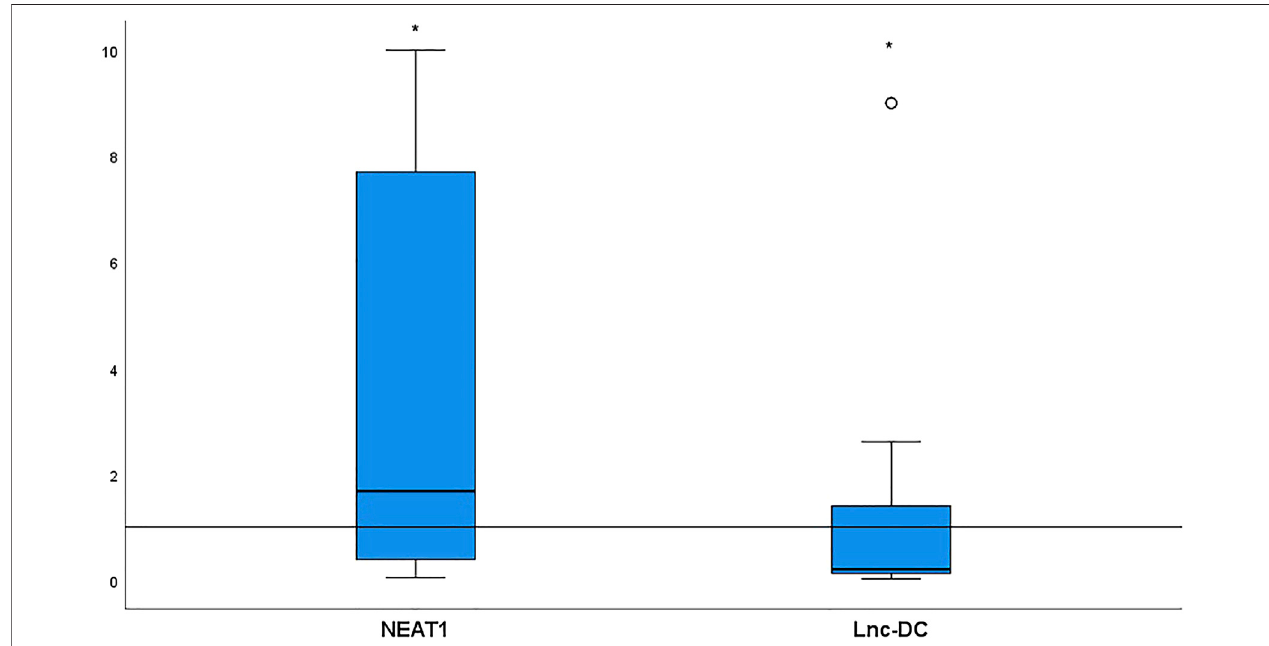
FIGURE 1| NEAT1 and lnc-DC expressions in serum from 52 BD patients relative to healthy controls. Data are represented by box plot (median, upper, and lower quartiles). The horizontal dotted line represents transcript expression in the control group, which is 1 according to the 2 − ΔΔ Ct equation. The increase of NEAT1 ( p < 0.0001) and the decrease of lnc-DC ( p (cid:1) 0.03) were detected in total BD patients vs. healthy controls. *Signi fi cant.